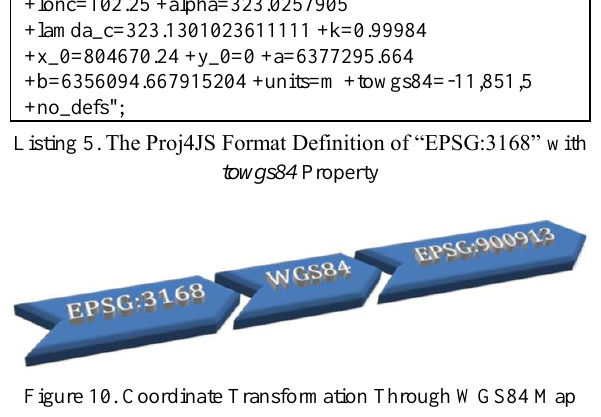
Figure 12. The Jalan Raya after Applying Datum Transformation